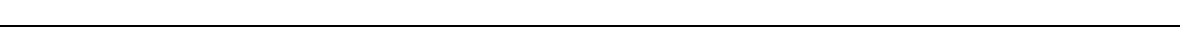
Fig. 5 KSRP binds to pri-129-1 transcripts in myeloid cells. a RNAfold software was used to predict the secondary structure of the pri-129-1 transcripts, and the four KSRP-binding sites are highlighted. b Schematic representation of the three pairs of primers used in the RIP assay. c Agarose gel electrophoresis showing the results of the RIP assay in THP-1 cells. d RIP-qPCR analysis of the co-precipitation of the pri-129-1, pri-23b and pri-let7a transcripts by the KSRP antibody compared to the IgG control. Three technical replicates from a single experiment. e Schematic representation of an RNA pull-down assay using MS2-tagged pri-129-1 af fi nity puri fi cation. f Immunoblot of endogenous KSRP in RNA pull-down assays from 293 T cells transfected with either MS2- tagged wild-type pri-129-1 (129_WT-MS2) or non-MS2-tagged pri-129-1 (129_WT). An unrelated protein (GAPDH) was used as the control. g Immunoblot of endogenous KSRP in competitive RNA pull-down assays from 293T cells co-transfected with 129_WT-MS2 and increasing doses of 129_WT. h Upper: schematic representation of the construction of the KSRP-binding site mutant plasmids; lower: immunoblot of endogenous KSRP in the RNA pull-down assay from 293 T cells transfected with either the MS2-tagged wild-type pri-129-1 (129_WT-MS2) or the MS2-tagged KSRP-binding site mutant (129_mut1-MS2, 129_mut2-MS2, 129_mut3-MS2, 129_mut4-MS2 and 129_mutF-MS2) constructs. i Schematic representation of the RNA transcripts and DNA probe sequences used in the RNase H protection assay. j RNase H protection assay using probes in i . Size of markers for both clones are the same. k Quantitation of the KSRP protection ef fi ciency using Image Pro, as indicated in j . Three technical replicates from a single experiment. Data are shown as means ± s.d. *** P < 0.001, Student ’ s t